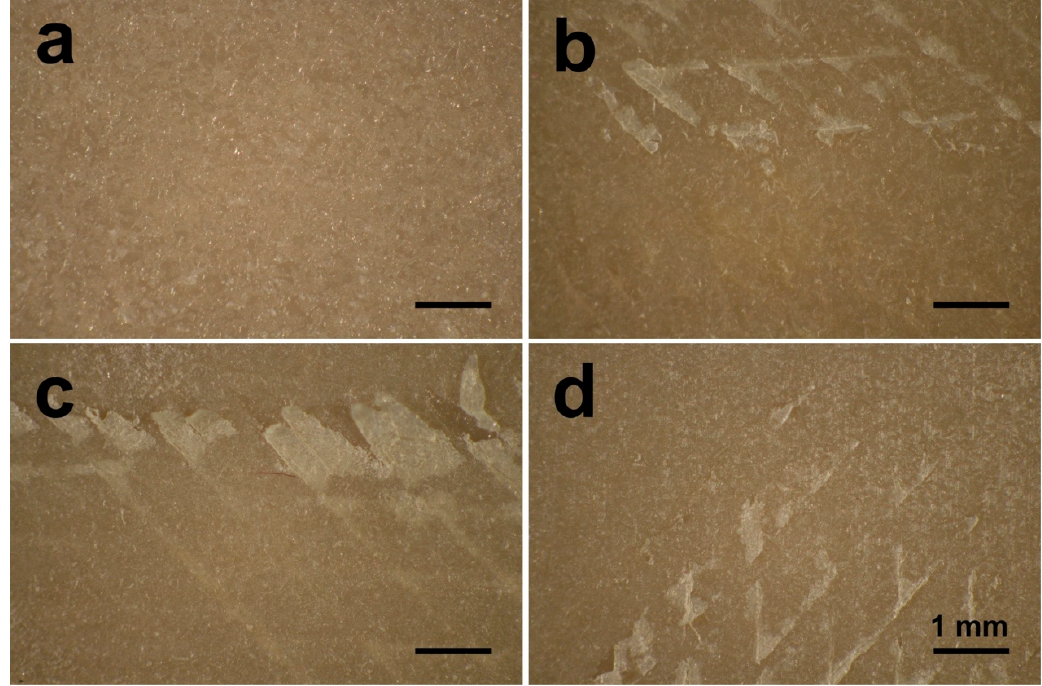
Figure 7. Optical micrographs of the grit-blasted PEEK samples after different grit-blasting procedures: ( a ) distance: 50 mm, pressure: 0.1 MPa, time: 15 s; ( b ) distance: 10 mm, pressure: 0.1 MPa, time: 15 s; ( c ) distance: 50 mm, pressure: 0.5 MPa, time: 15 s; ( d ) distance: 50 mm, pressure: 0.1 MPa, time: 60 s [10].